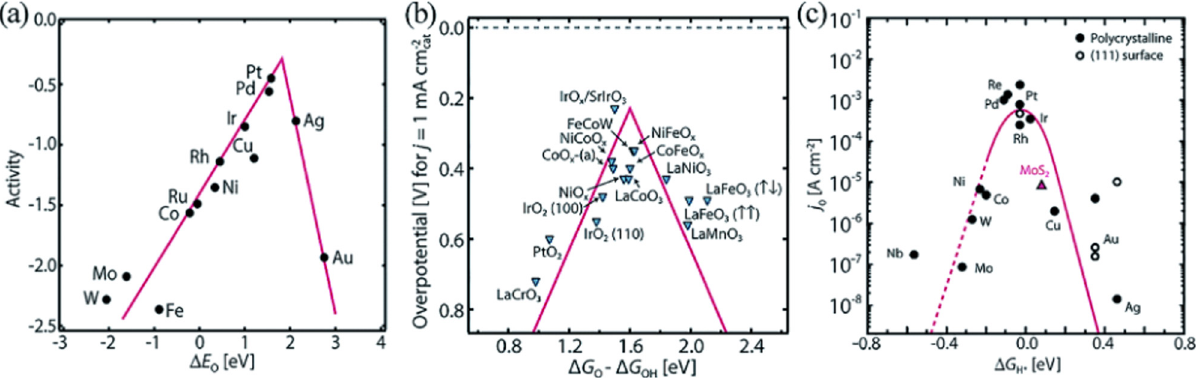
Figure 2: ( a ) Metals volcano plot for the ORR system redrawn from [ 21 ] , copyright 2017, WILEY - VCH; ( b ) Metal oxides volcano plot for OER system redrawn from [ 44 ] , copyright 2017, American Association for the Advancement of Science; ( c ) metals volcano plot for the HER system redrawn from [ 44 ] , copyright 2017, American Association for the Advancement of